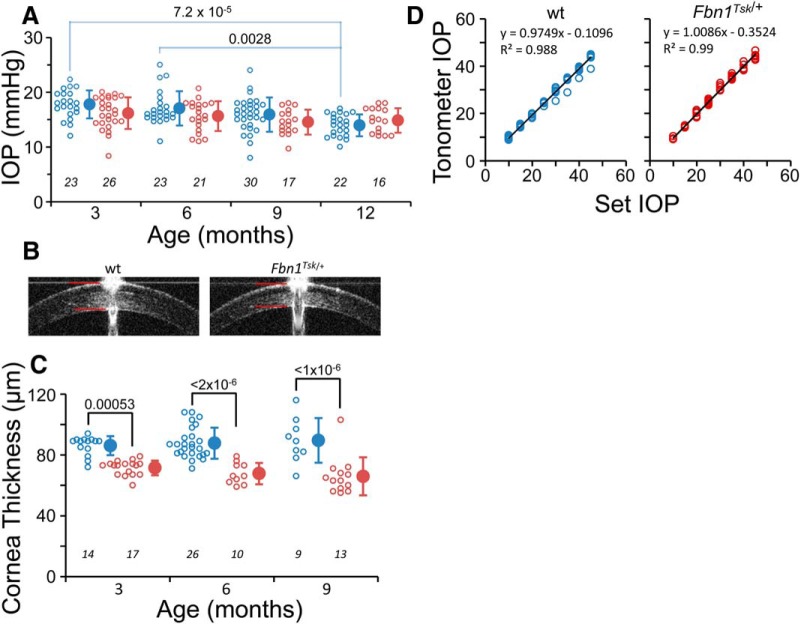
IOP is not affected by microfibril deficiency. Fbn1Tsk
/+ (red symbols) and wt mice (blue symbols) had similar IOPs at three, six, nine, and 12 months of age (A). Central cornea thickness measured by SD-OCT imaging (B, red lines) was significantly thinner in Fbn1Tsk
/+ mice at three, six, and nine months (C). Tonometer calibration was not affected by difference in corneal thickness (D, black lines: linear best fits, 10 wt and six Fbn1Tsk
/+ mice). Open symbols: individual mice, closed symbols: mean ± SD. Numbers of mice indicated in italics below each group (A, C). Representative SD-OCT images are from three-month-old mice (B).